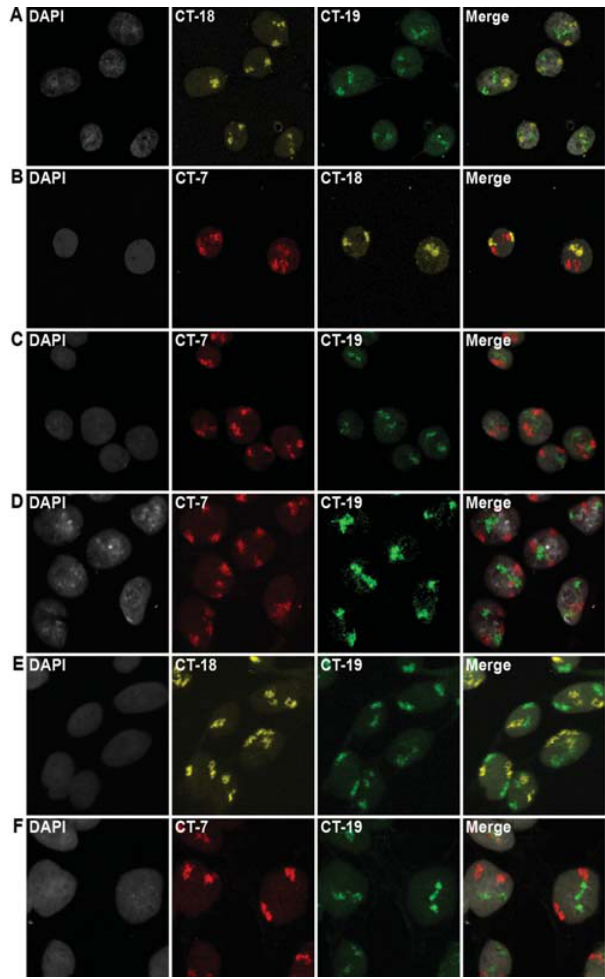
Figure 2. Representative maximum intensity projection of confocal image stacks from DLD-1 parental and derived nuclei. A–C: Parental DLD-1 nuclei. D: DLD-1 + 7 nuclei. E: DLD-1 + 18 nuclei. F: DLD-1 + 19 nuclei. DAPI: DNA counterstain; CT-7: Chromosome 7; CT-18: Chromo- some 18; CT-19: Chromosome 19; Merge: merged image of DAPI and chromosome territories.